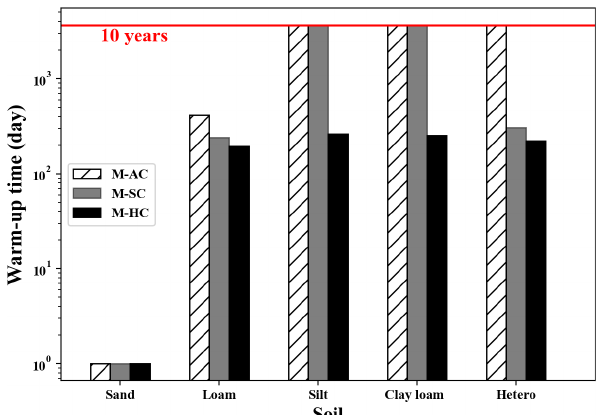
Figure 4. The length of warm-up time t wu with various soils and meteorological conditions. Note that some of the t wu values are larger than 10 years and are not able to be obtained due to the 10-year simulation time. The heterogeneous soil profile consists of loam (0–75cm), clay loam (75–150cm), silt (150–225cm) and sand